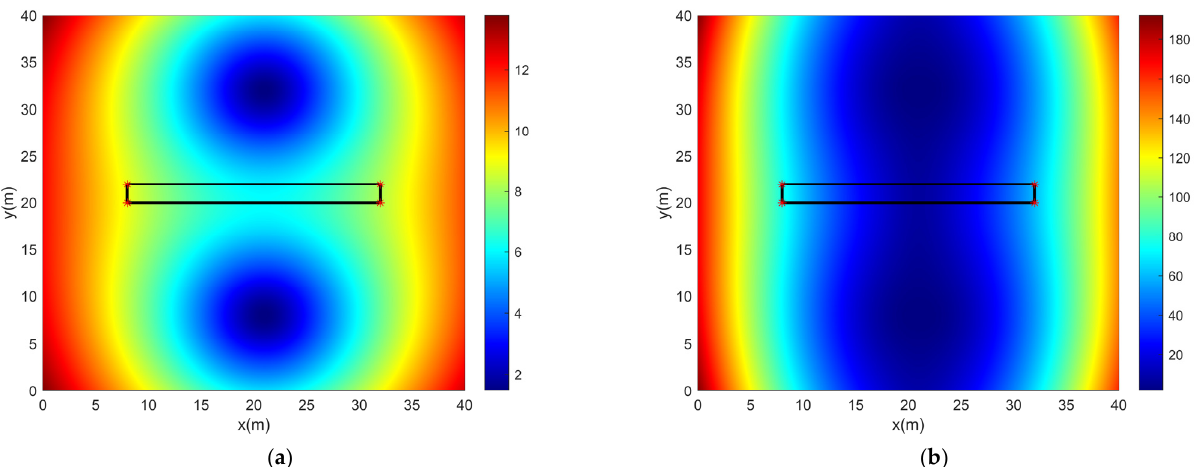
Figure 6. DOP values in corridor simulation space: ( a ) HDOP values; ( b ) PDOP values.